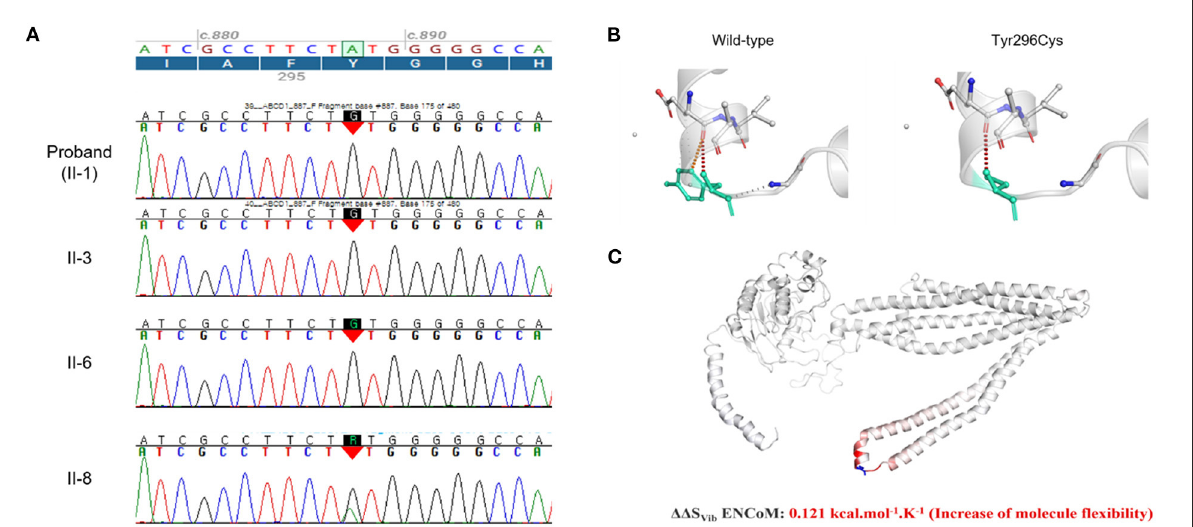
FIGURE3 (A) Sanger sequencing confirmed a hemizygous missense variant (c.887A > G, p.Tyr296Cys) of the ATP-binding cassette subfamily D member 1 gene ( ABCD1 ) (NM_000033.4) that had been identified using whole-exome sequencing for the genome of the affected members (II-1, II-3, and II-6). The same variant was detected in a heterozygous state in the asymptomatic female carrier (II-8). (B) Wild-type and mutant residues (p.Tyr296Cys) in the ABCD1 protein are colored light-green and represented as sticks alongside the surrounding residues, which were involved in any interaction type. Red dots are hydrogen bonds, with orange representing weak ones. The crystal structure of the domain from wild-type ABCD1 isoform 1 was generated using SWISS-MODEL (https://swissmodel.expasy.org/) and is depicted as a cartoon representation. (C) Results obtained using other predictive tools (NMA based and other structure-based approaches) are also displayed, which predict the effect of the mutation using the DynaMut web-server with the normal mode analysis function (http://biosig.unimelb.edu.au/dynamut/). Visual representation of the 1 vibrational entropy energy in which the amino acids are colored according to the vibrational entropy change upon mutation. Blue regions indicate rigidification and red regions indicate an increase in